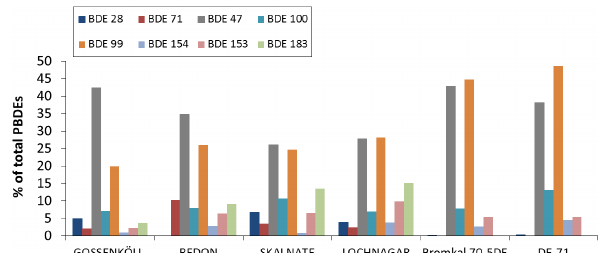
Fig. 4. Relative distribution of PBDEs in atmospheric deposition samples from the studied sites. The distributions were dominated by BDE209 in all cases but this compound is not included in the plots. The composition of the pentaBDE technical mixtures is included for